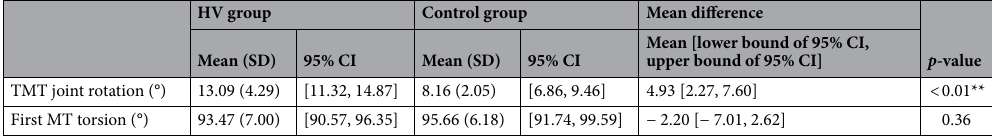
Table 2. Results of 1TMT joint rotation and the first MT torsion in two groups. *The correlation is significant with p-value < 0.05. **The correlation is significant with p-value <